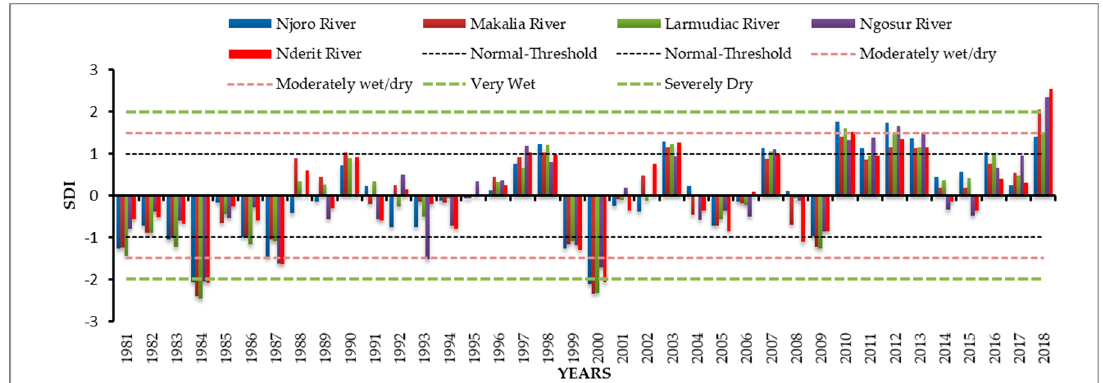
Table 7. Distribution of wet and dry periods for 12-month SDI for Lake Nakuru catchment from 1981 to 2018 and from 2009 to 2018.